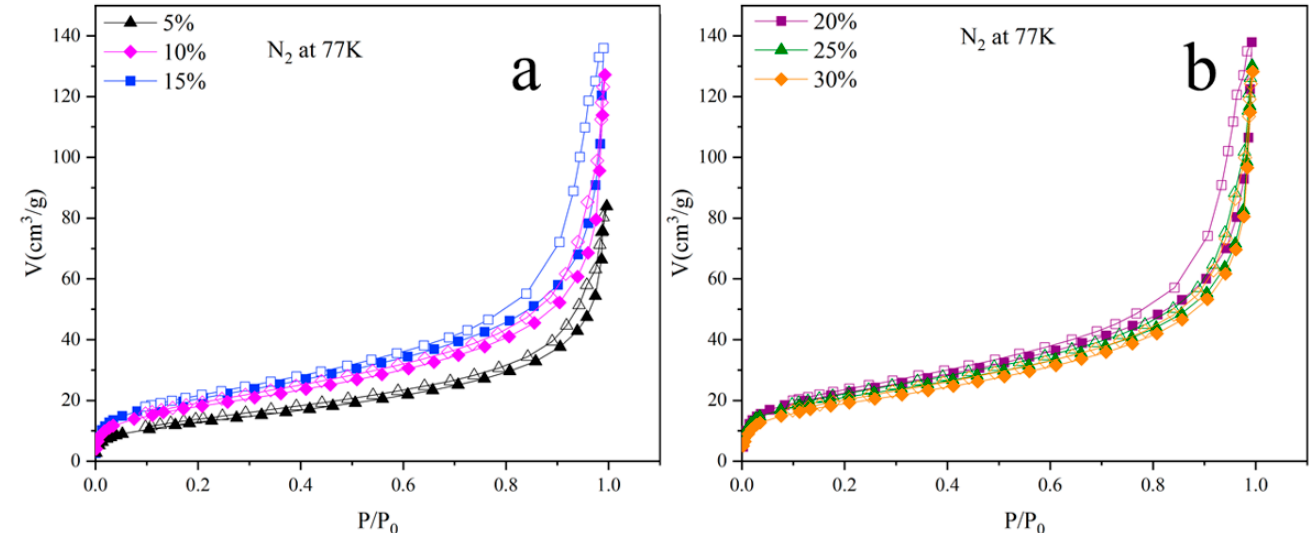
Figure 5. The adsorption–desorption isotherm of aerogels with different doping amounts ( a : 5%, 10%, 15%); ( b : 20%, 25%, 30%).